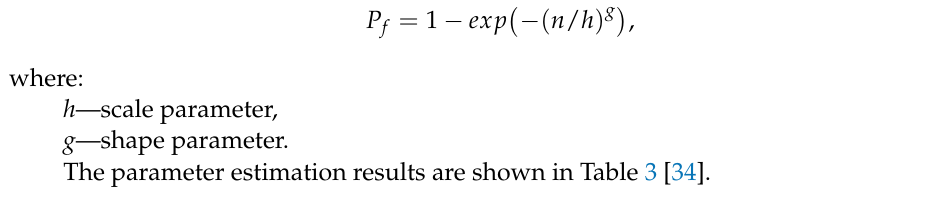
Table 3. Parameters of Weibull distribution for fatigue lives of LY12-CZ aluminium alloy. Stress Amplitude σ a , MPa